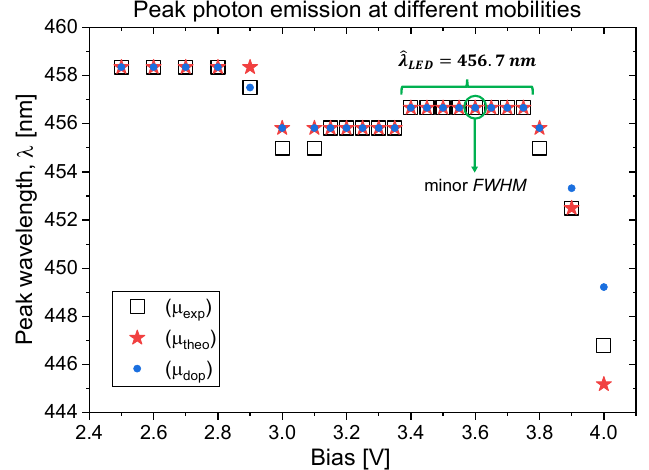
Figure 12. Peak photon emission for the three simulations with experimental, theoretical, and dop-